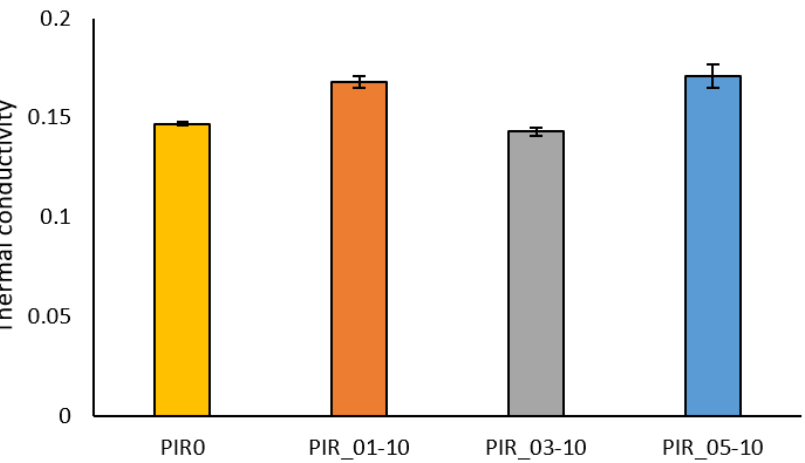
Figure 13. Effect of particle size on the thermal conductivity of reinforced Polyisocyanurate foams.